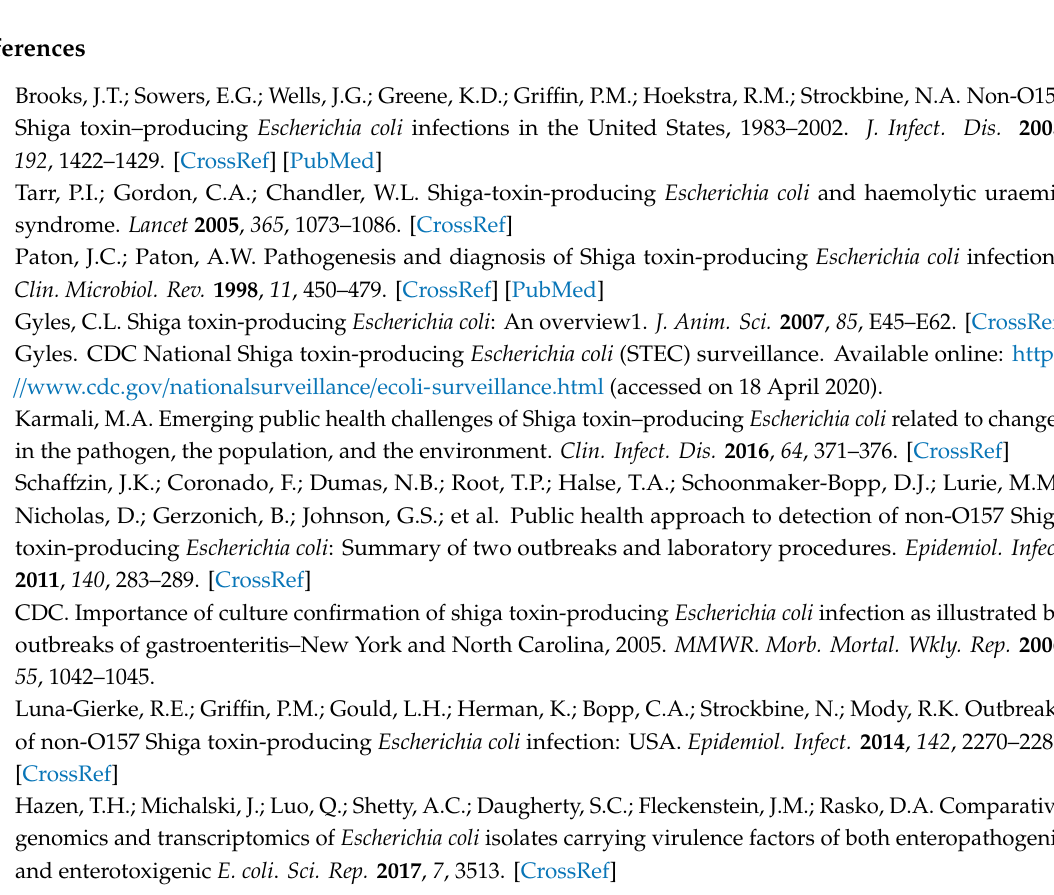
Table S1: Information on reference Shiga toxin-producing E. coli genomes obtained from NCBI in this study. Author Contributions: Y.Z. was responsible for strain preparation, data analysis, and manuscript